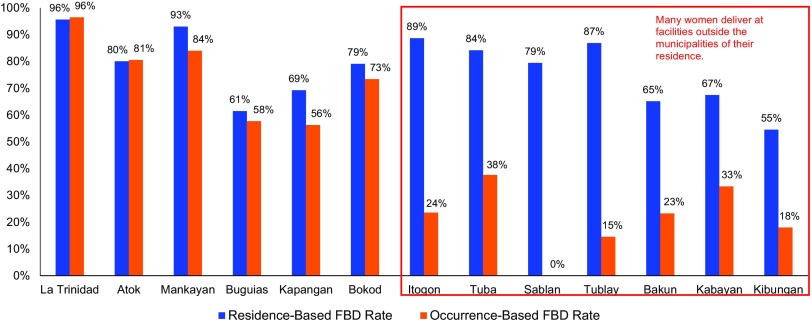
Facility-Based Delivery Rates of 13 Municipalities in Benguet Province, Philippines, 2012, by Computational MethodSource: MCH-CAR project7 and Department of Health [Philippines].8